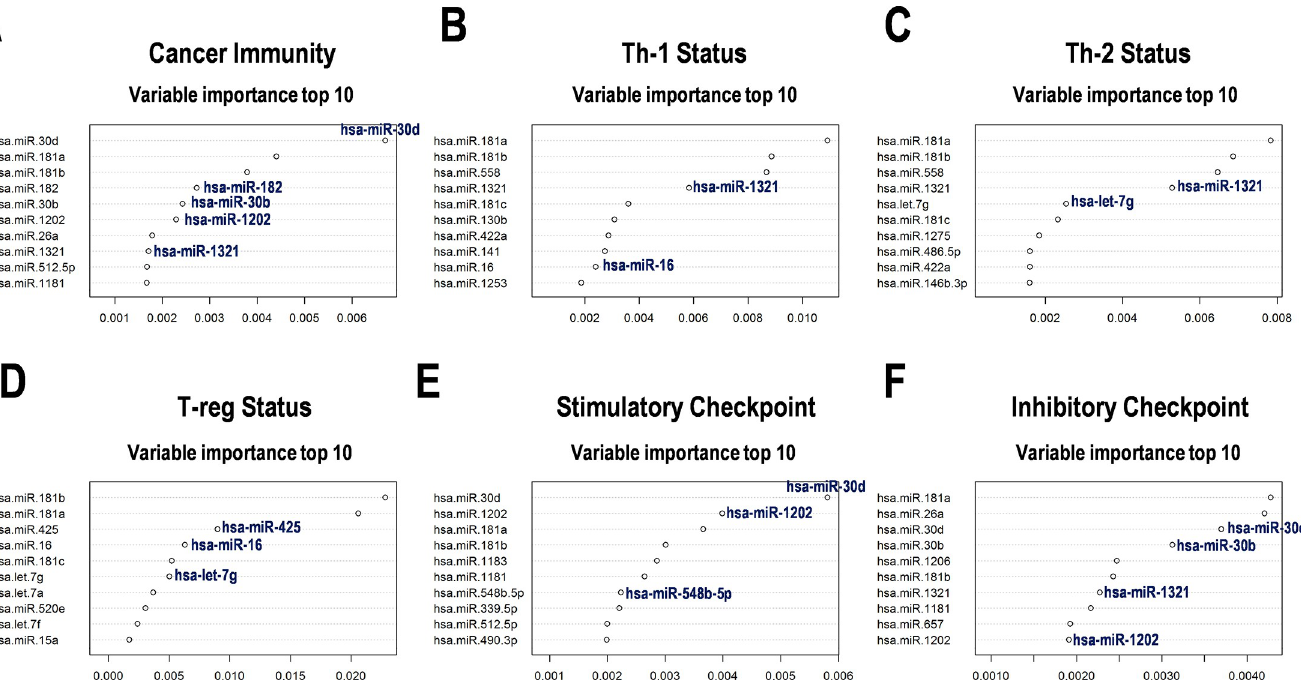
Fig 2. Variable importance of the cancer immunity-related miRNAs with the random survival forests analysis in the PCNSL patients. Variable importance of representative miRNAs involved in ( A ) cancer immunity; ( B ) subgroups including Th-1 status, ( C )Th-2 status, ( D ) regulatory T-cell (T-reg) status, ( E ) stimulatory checkpoint, and ( F ) inhibitory